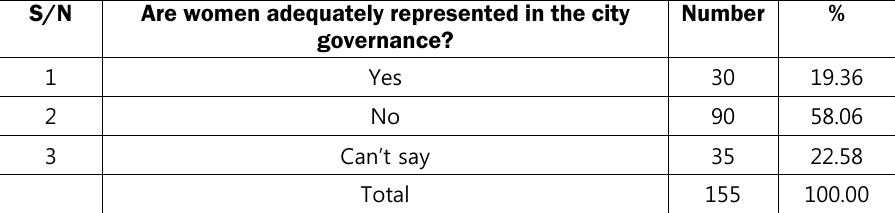
TABLE 5: Citizens’ views about representation of women in the city governance S/N Are women adequately represented in the city